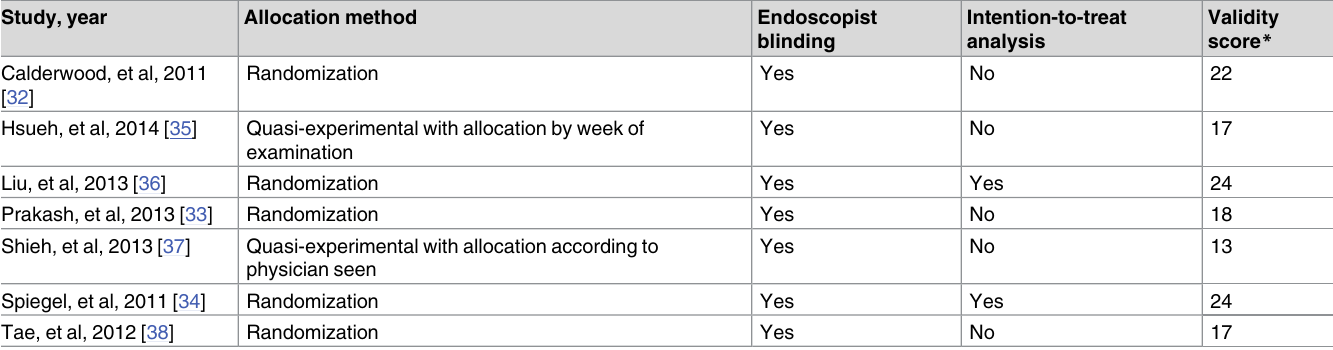
Table 2. Assessment of risk of bias for full-text studies included in